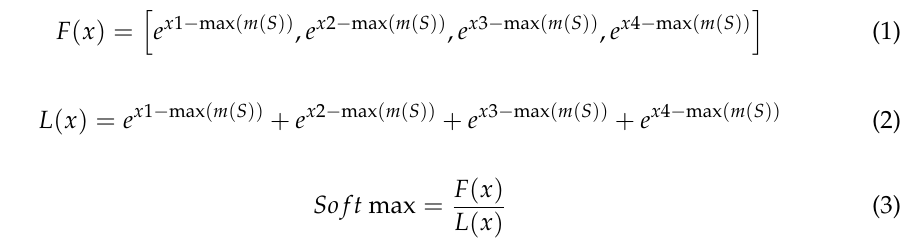
Figure 2. Q, K, and V structure of flash attention.